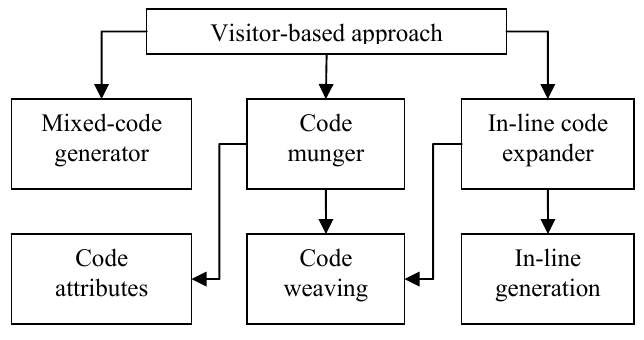
Fig. 3. Visitor-based approach